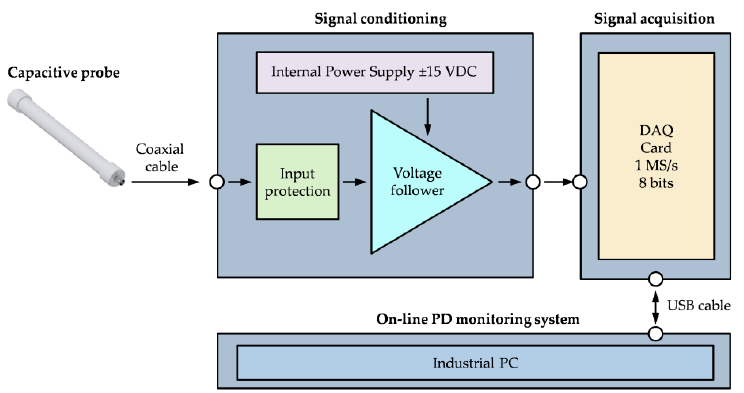
Figure 7. Schematic diagram of non-contact high voltage measurement with the use of a capacitive probe for an autonomous online partial discharge monitoring system.